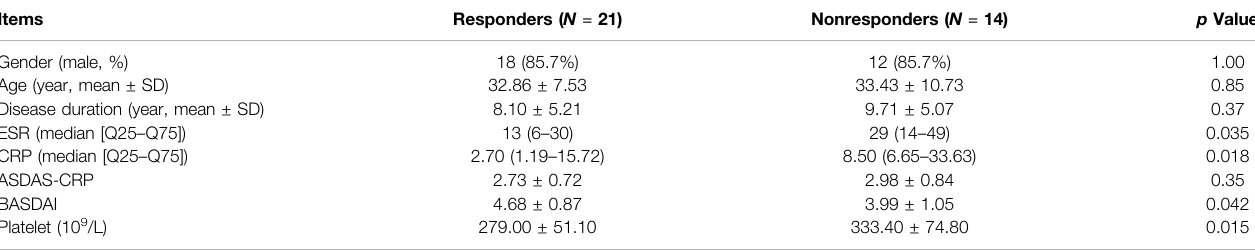
TABLE 1 | Differences in baseline clinical characteristics between responders and nonresponders. Items